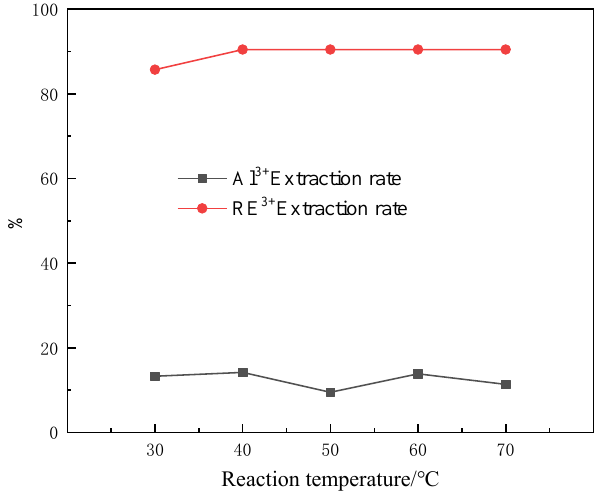
Figure 5. Effect of reaction temperature on the separation of rare earths and aluminum.